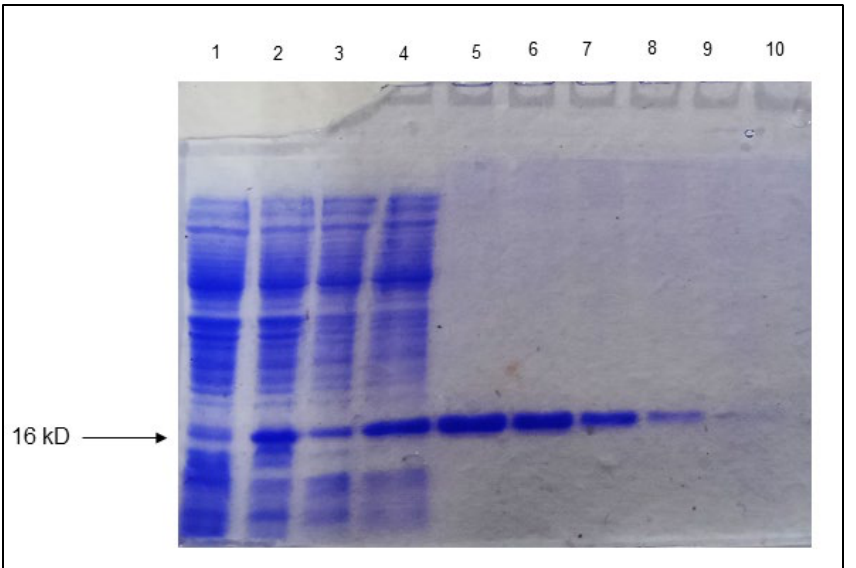
Figure 6. Protein purification : Protein purification of Rv1636: Lane 1 and 2: uninduced Rv1636 and induced Rv1636, Lane 3: wash 1, Lane 4: wash 2, Lane 5–10: Purified Rv1636 fractions 1, 2, 3, 5, and 7.